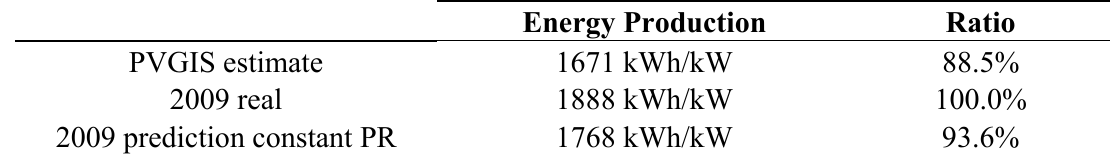
Table 4. PVGIS estimate for an average year, real EP in 2009, and predicted EP in 2009 using constant PR, for the Puertollano CPV installation in 2009.